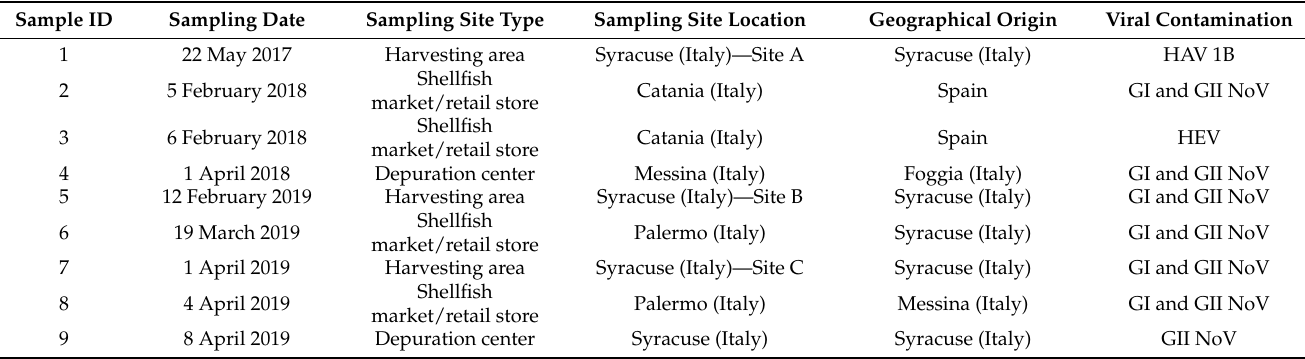
Table 4. Detailed traceability data of the viral contaminated shellfish resulted from the study. All virus-positive samples were identified as Mytilus galloprovincialis